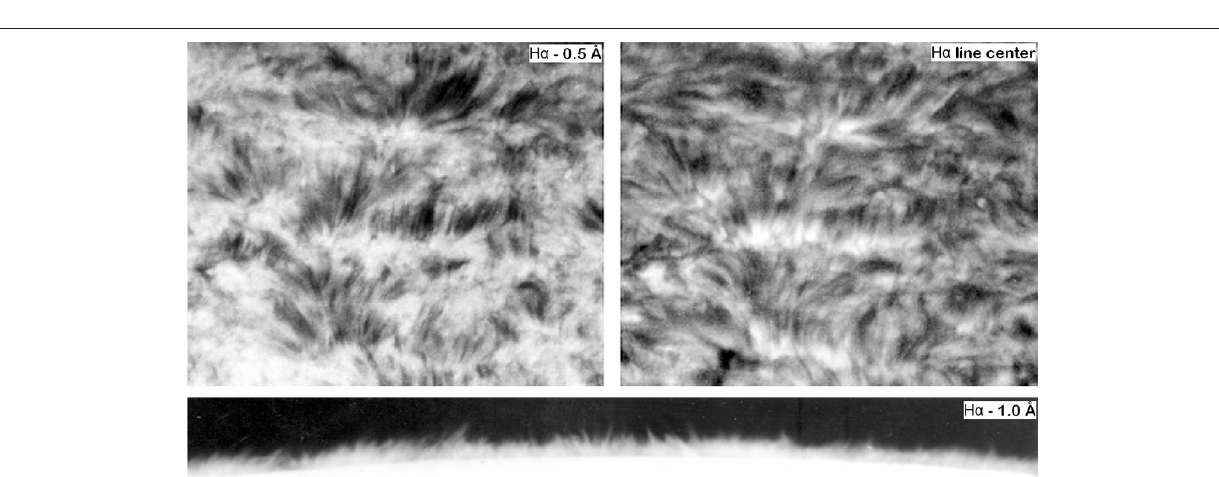
FIGURE 9 | (Top) A chromospheric region far from the center of the solar disk, in the blue wing of H α (left) and in the center of the line (right). The field of view is 95 ′′ by 80 ′′ . Photographs by the author with the 40cm Tourelle refractor at the Pic du Midi Observatory on September 27, 1979. (Bottom) Spicules at the limb, in the blue wing the H α line. Observed by R. D. Dunn with the Vacuum Tower Telescope (now the Dunn Telescope) of the Sacramento Peak Observatory in 1970. Image adapted by the author from a figure published in Lynch et al.